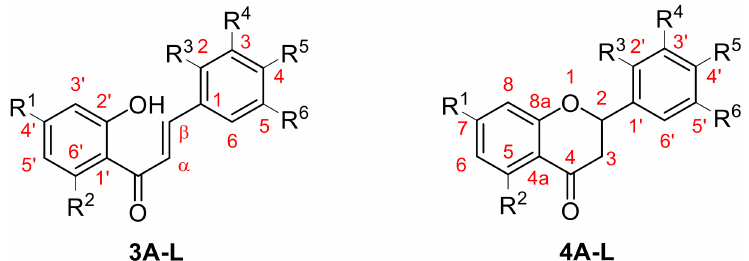
Figure 7. Structures of chalcone and flavanone